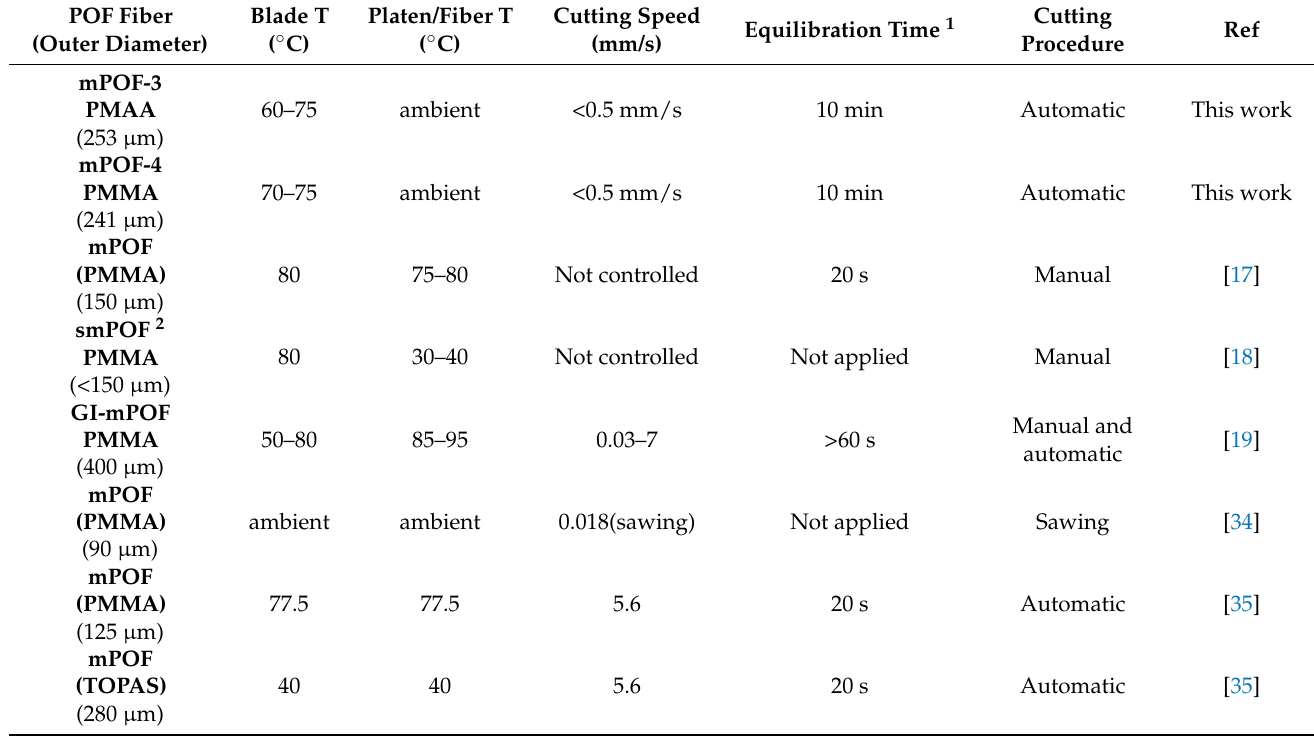
Table 1. Comparison between different mPOFs and their corresponding cleaving parameters reported. The values included correspond to optimal cleaving conditions determined from